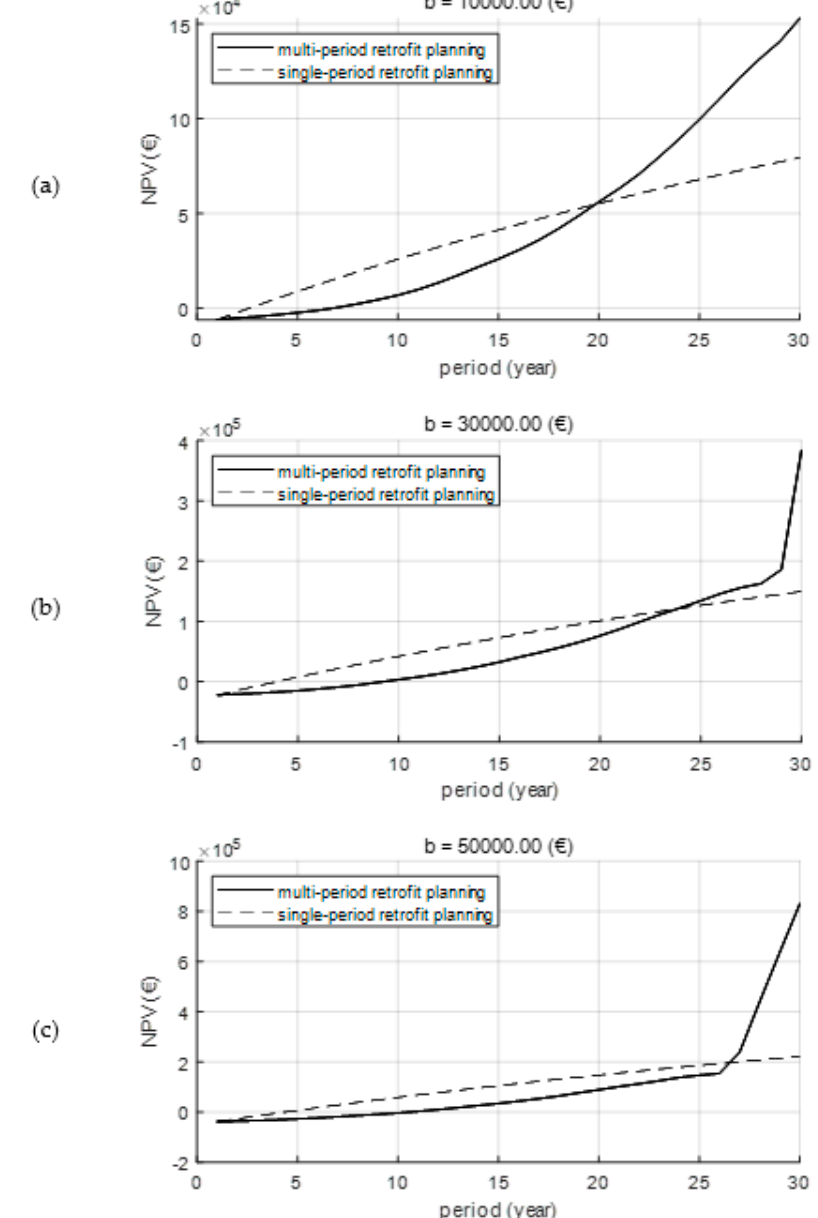
Figure 3. The NPVs over time intervals achieved by single- and multi-period retrofit planning for different initial investment budgets: ( a ) b = € 10,000.00, ( b ) b = € 30,000.00, and ( c ) b = €